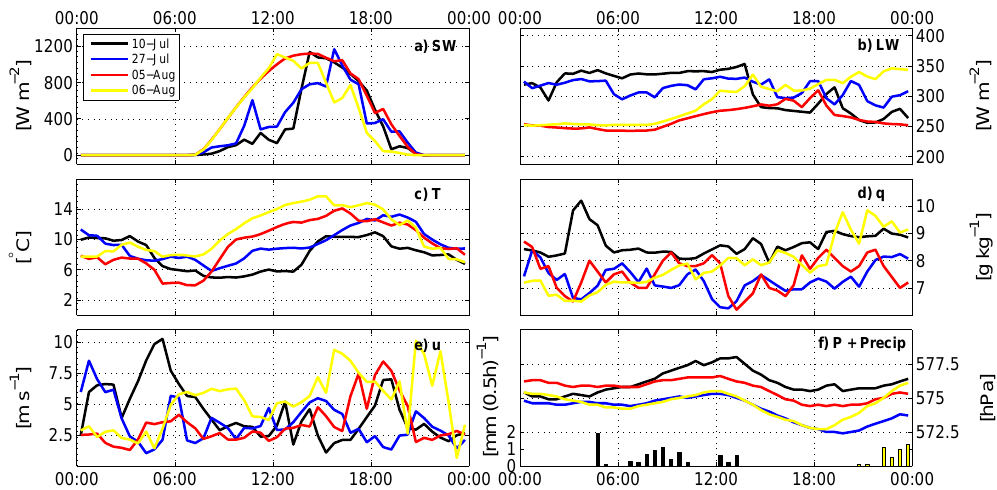
Fig. 2. Forcing data measured at UBT used for model runs: (a) downward shortwave radiation ( SW [Wm − 2 ]); b) downward longwave radiation ( LW [Wm − 2 ]); (c) air temperature ( T [ ◦ C]); (d) water vapour mixing ratio ( q [gkg − 1 ]); (e) wind speed ( U [ms − 1 ]); (f) surface pressure ( P [hPa]) and precipitation [mm ( 0 . 5h ) − 1 ]) Height c–e is